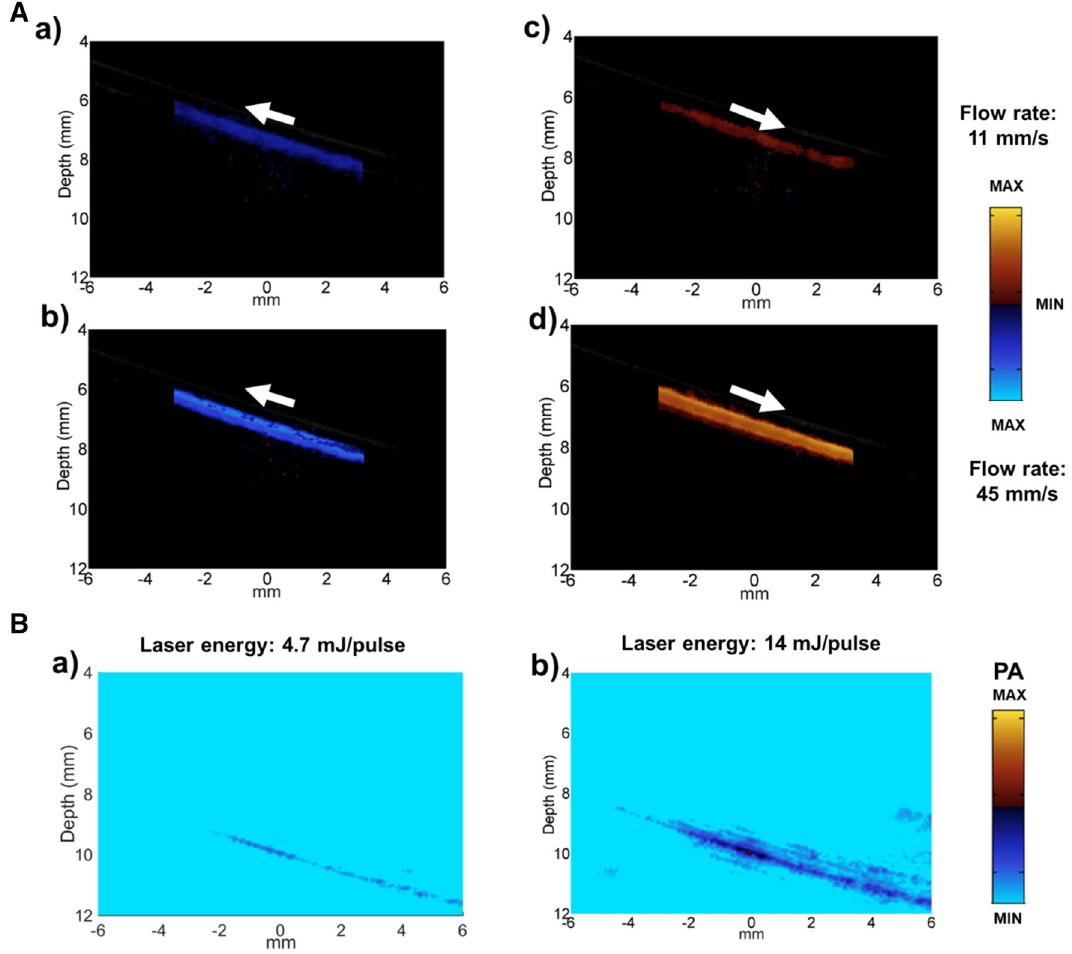
Figure 3. US flow and PA images of the microdroplets in transparent tubes: ( A ) US flow imaging with flow speed of 11 mm/s (a,c) and 45 mm/s (b,d). The white arrow indicates the flow direction ( B ) PA images with laser energy 4.7 mJ/pulse (subfigure a)) and 14 mJ/pulse (subfigure b)). The irradiation wavelength is 750